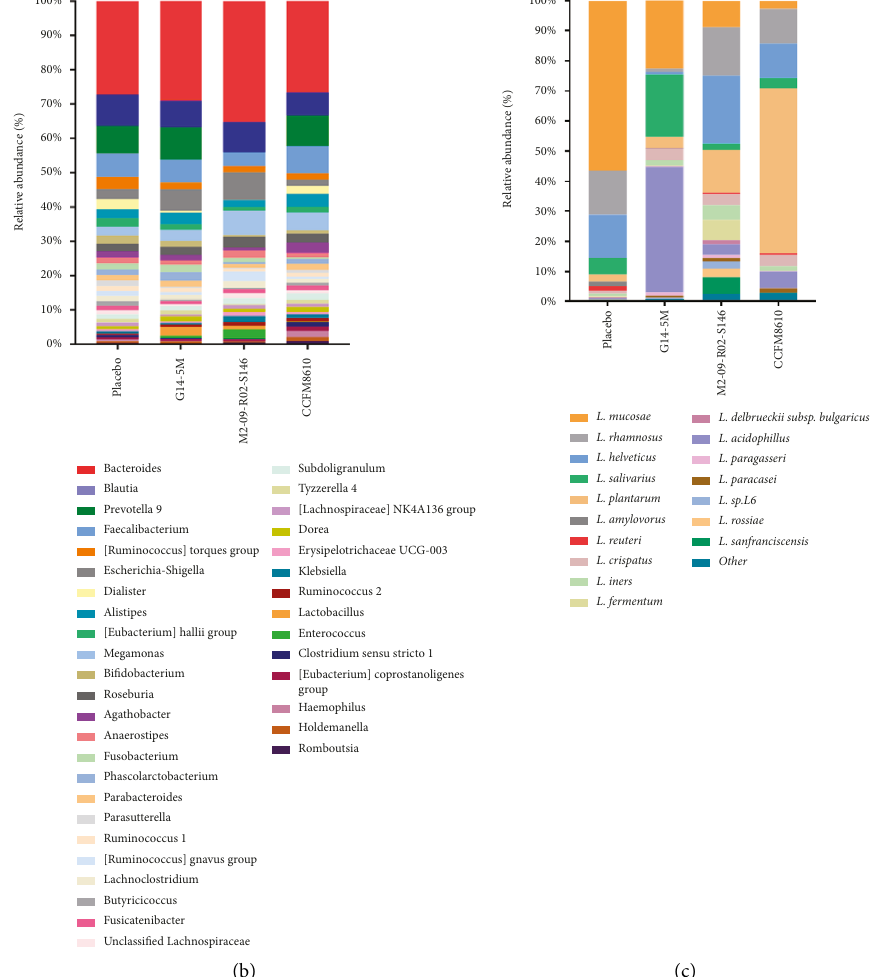
Figure 5: Composition and relative abundance of the gut microbiota at end-of-trial. (a) At the phylum level; (b) at the genus level; (c) at the Lactobacillus -species level. The species found at > 1% of the average in the total population are shown. Species found at < 1% are grouped as